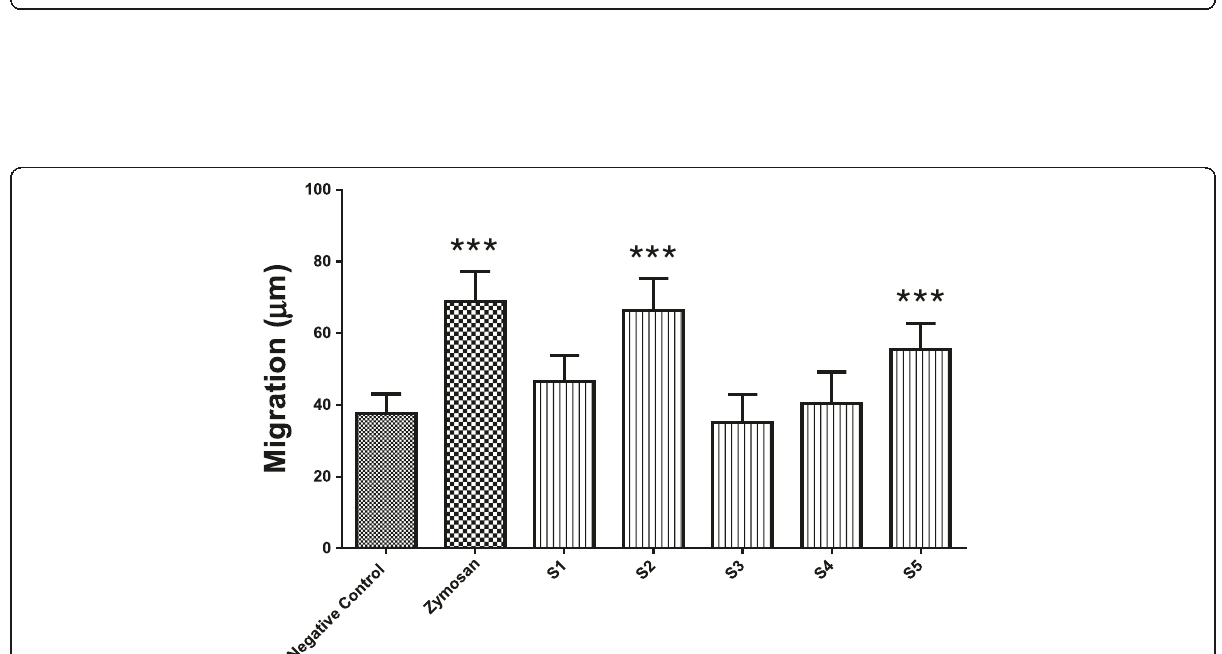
Fig. 5 Neutrophil chemotaxis induced by normal human serum (NHS) preincubated with fractions S1 - S5. The fractions were preincubated with NHS for 60 min at 37 °C. The positive control consisted of 120 μ L of NHS with 100 μ L of CFD/Gel buffer and 75 μ L of zymosan (1 mg/mL), while the negative control was 120 μ L of NHS with 100 μ L of CFD/Gel buffer. Neutrophil migration was assessed by the leading-front technique, in which at least ten microscopic fields were analyzed per filter at 100× magnification. The columns represent the means± SEM of one experiment done in triplicate. *** p < 0.001 compared to the negative control